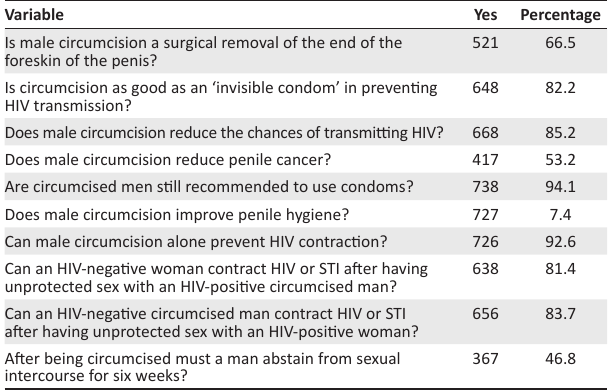
TABLE 2: Proportion of respondents who answered correctly to the knowledge questions about circumcision ( n = 784).